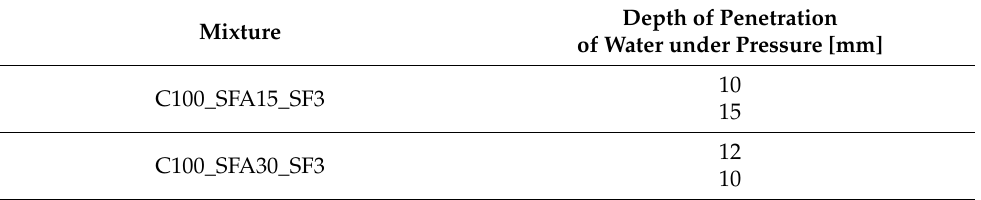
Table 9. Depth of penetration of water under pressure for HPC with 100% CEM III/B as a main